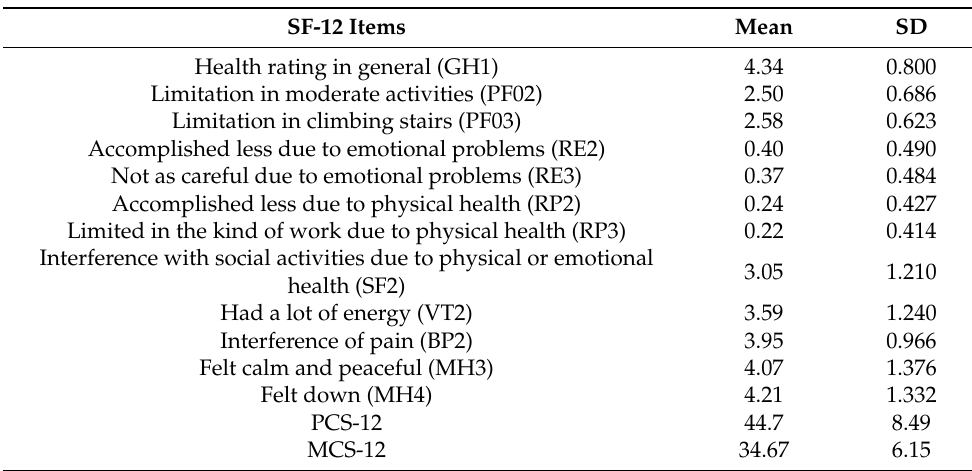
Table 2. Mean score of the health-related quality-of-life short-form scale in the studied sample (N =